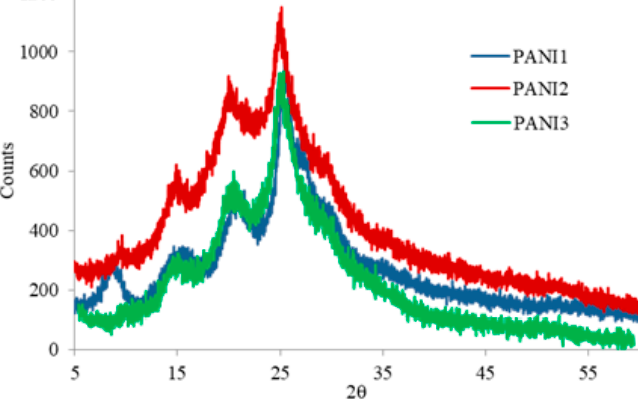
Figure 4. XRPD patterns of PANI1, PANI2 and PANI3.